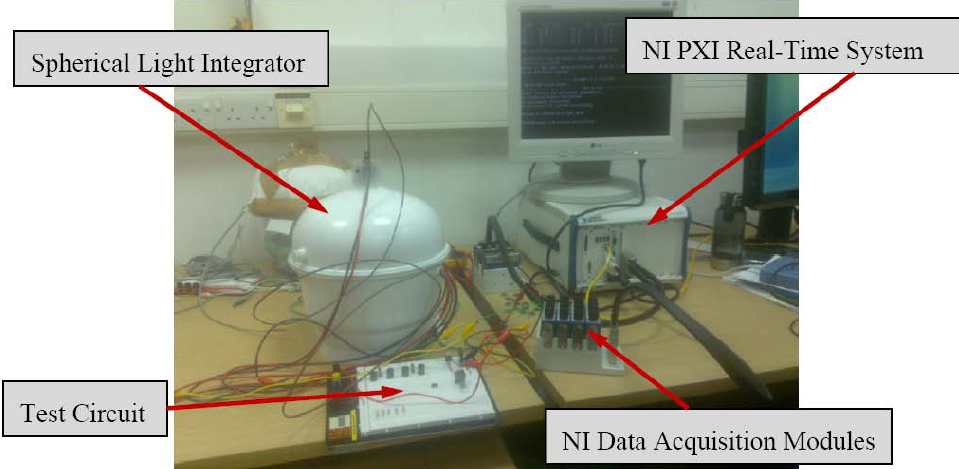
Figure 7. Test bench–Experiment setup with National Instruments’ PXI